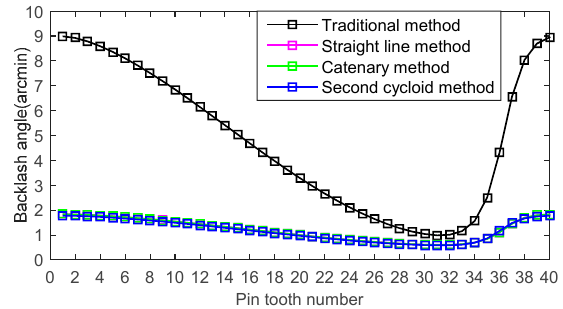
Figure 13. Minimum backlash curves of modified tooth profiles.